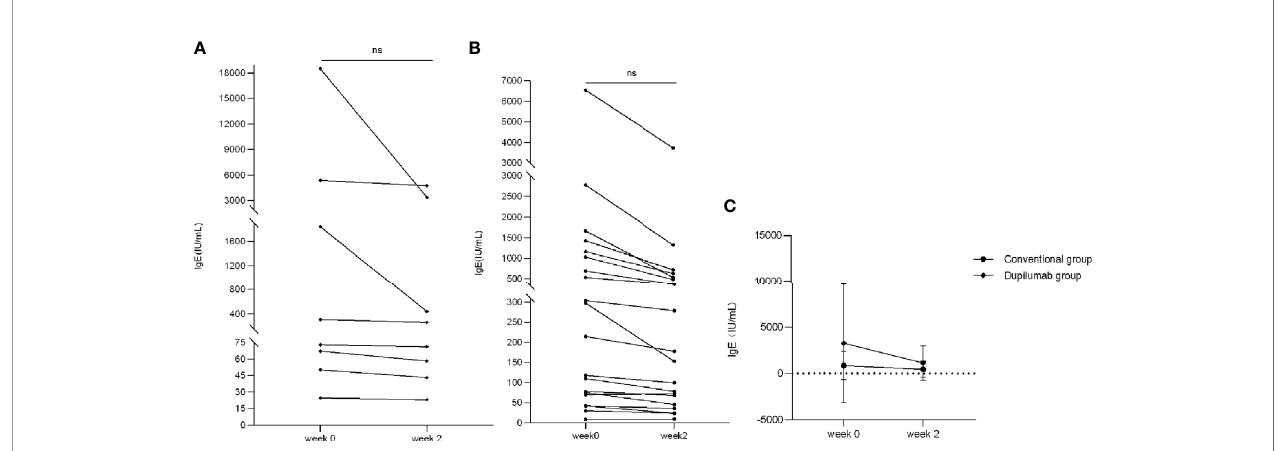
( Figure 6A : dupilumab group, Figure 6B : conventional group; p > 0.05, Mann-Whitney U test). In addition, there was no signi fi cant difference in declining patients ’ IgE between groups ( Figure 6C , p > 0.05, two-way RM ANOVA).